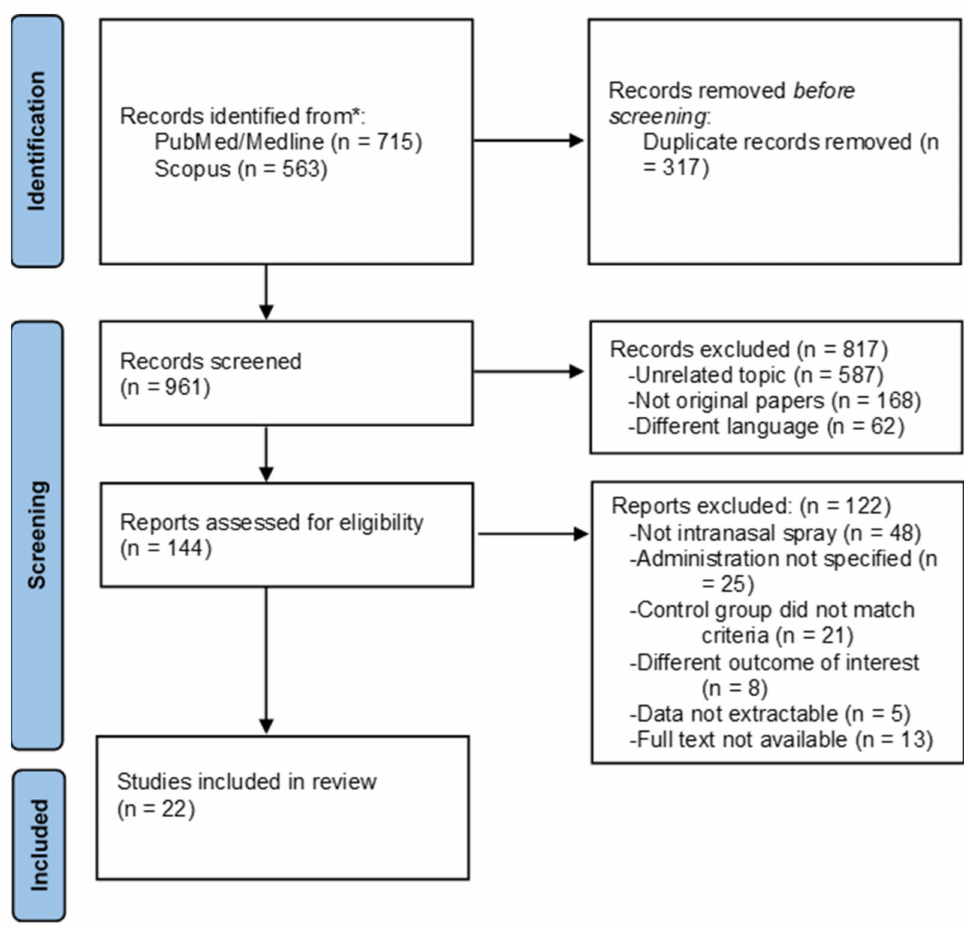
Figure 1. Flow diagram of the selection